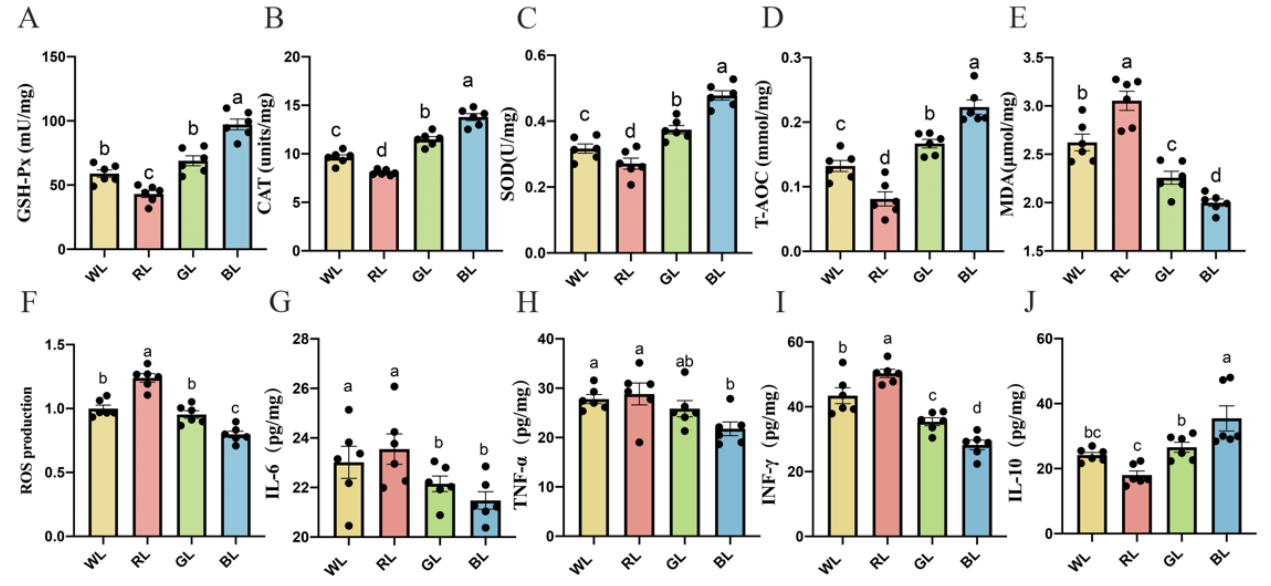
Figure 6. Effect of different monochromatic lights on GSH-Px ( A ), CAT ( B ), SOD ( C ), T-AOC ( D ), MDA ( E ), ROS ( F ), IL-6 ( G ), TNF- α ( H ), IFN- γ ( I ) and IL-10 ( J ) concentrations in the jejunums of WL, RL, GL and BL at P42. WL: white light; RL: red light; GL: green light; BL: blue light. These results are shown as means ± SEM. Differences between the four groups are presented in the form of different letters ( p < 0.05).